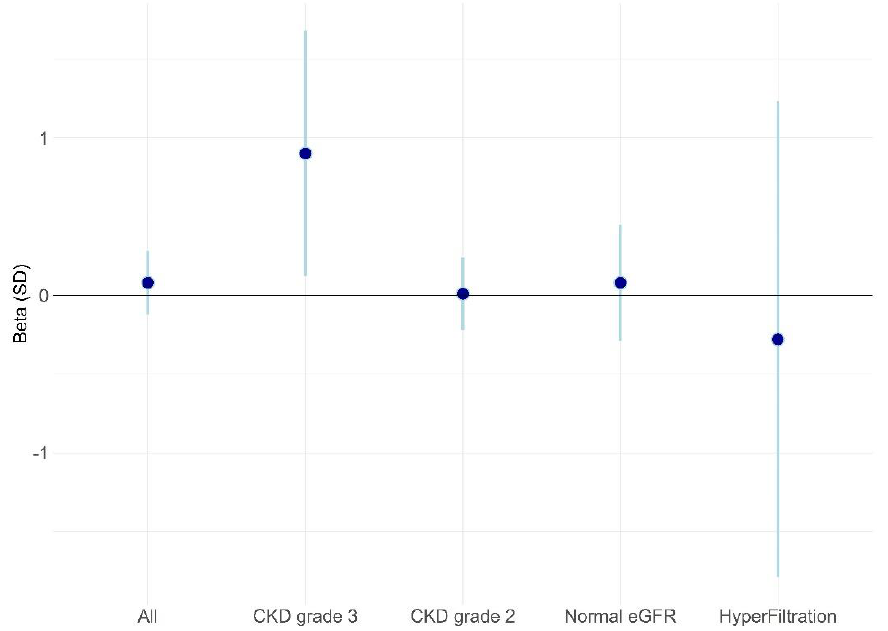
Figure 3. Evolution of MDRD classes over time (%).